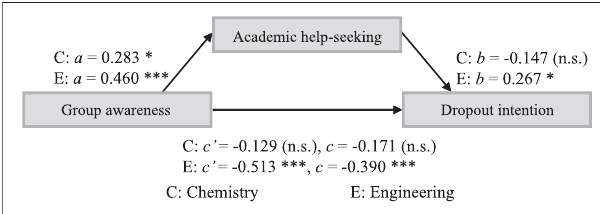
FIGURE 4 | Mediation model relationship between group awareness and student ’ s dropout intention via academic help-seeking. Note. * p ≤ 0.05, ** p ≤ 0.01, *** p ≤